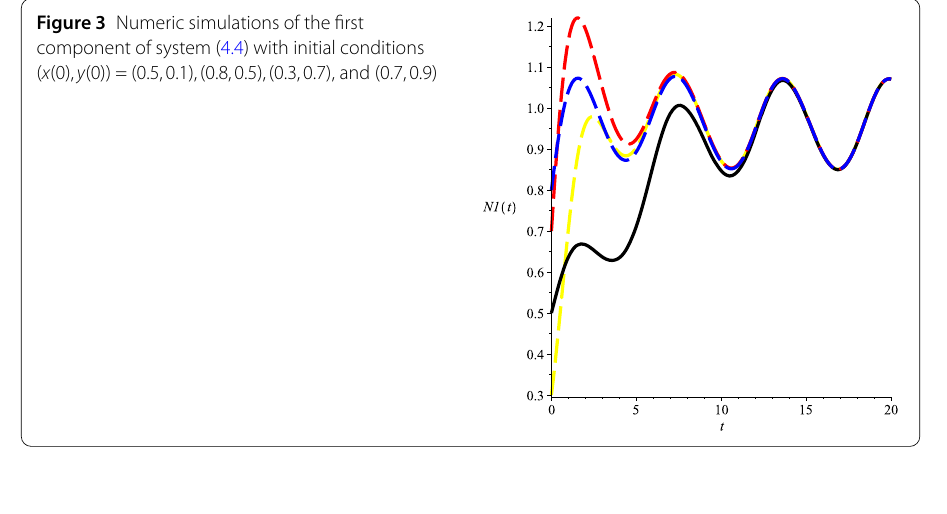
Figure 4 Numeric simulations of the second component of system (4.4) with initial conditions ( x (0), y (0)) = (0.5,0.1),(0.8,0.5),(0.3,0.7), and